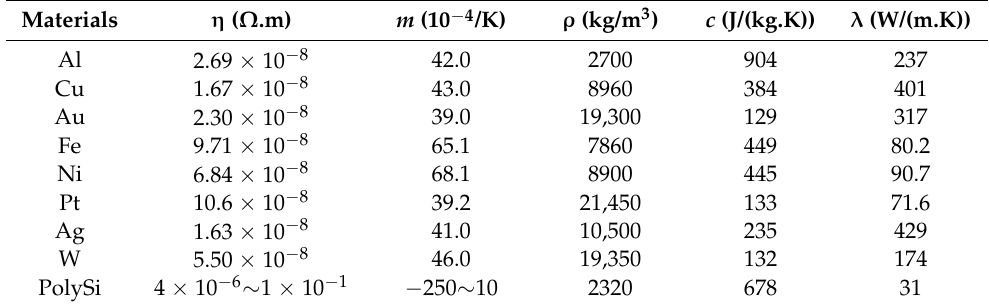
Table 2. Characteristics of materials suitable for microheaters at room temperature